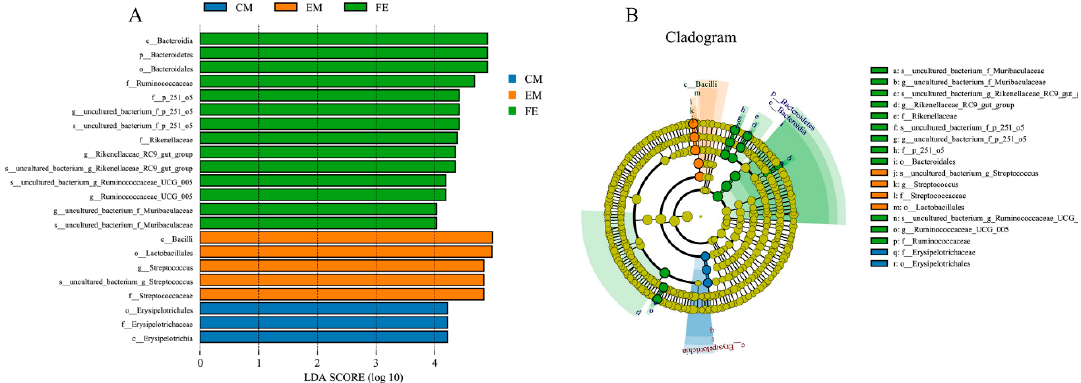
Figure 4. LDA value distribution histogram ( A ) and LEfSe analysis evolution branch diagram ( B ).